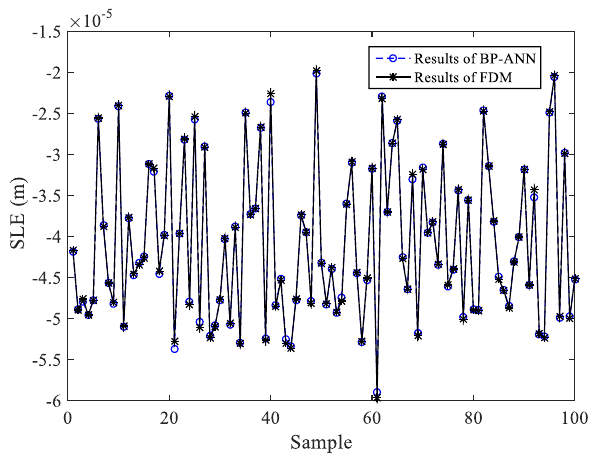
Figure 8. Reliability of the milling